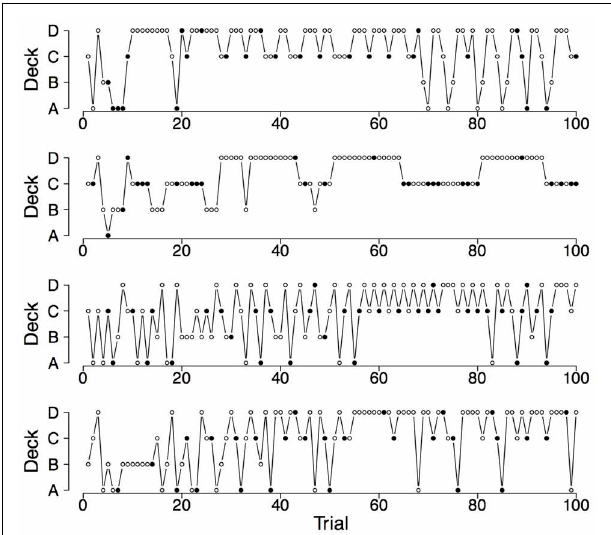
FIGURE 2 | Deck selection profiles of four healthy participants showing a pronounced preference for the good decks. The filled dots indicate the occurrence of rewards and losses together; the empty dots indicate the occurrence of only rewards.